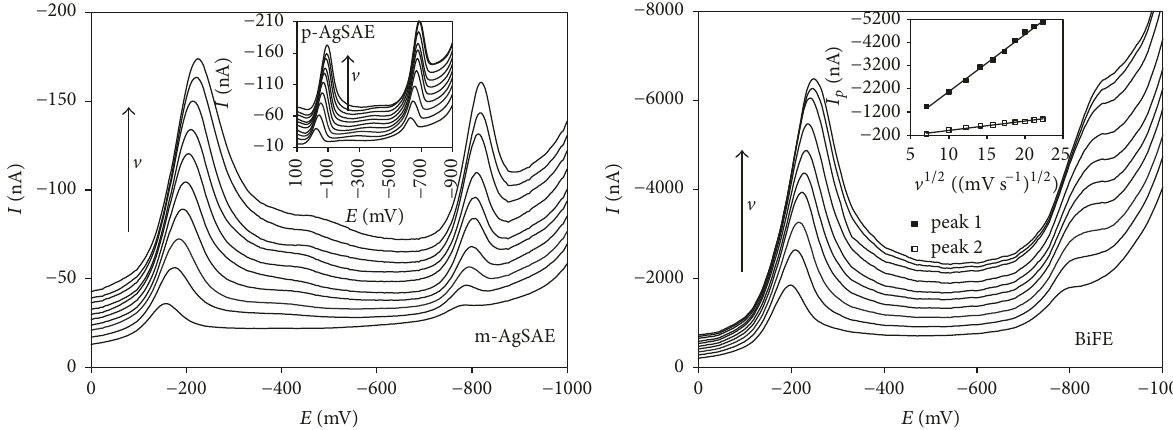
= 5.0 × 10 −6 mol L −1 ; (1) peak 1; (3) peak 3. DAN